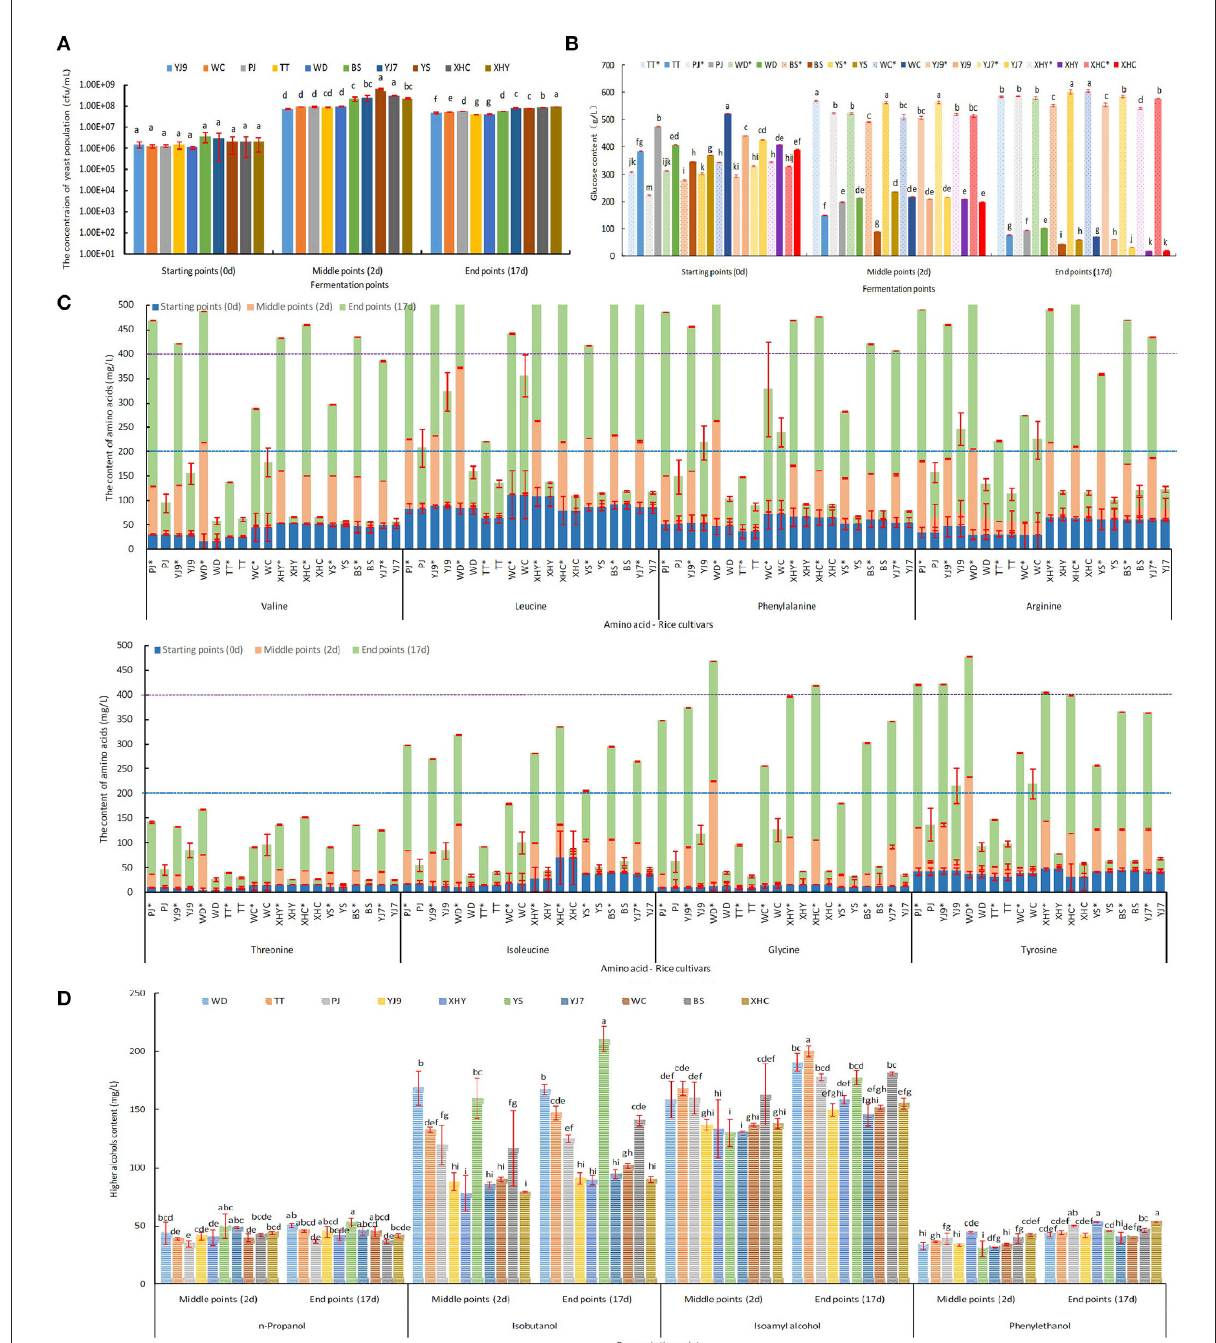
FIGURE1 The dynamics of yeast population (A) , glucose content (B) , eight free amino acids’ content (C) , and higher alcohols content (D) at different fermentation points. *Denotes the control panel without inoculation of S. cerevisiae . The letters (a, b, c, d, e, f, g) represent significant difference among different rice cultivars, which was analyzed by one-way ANOVA ( P < 0.05). The significant difference in free amino acids content among rice cultivars is given in Supplementary Table 1.